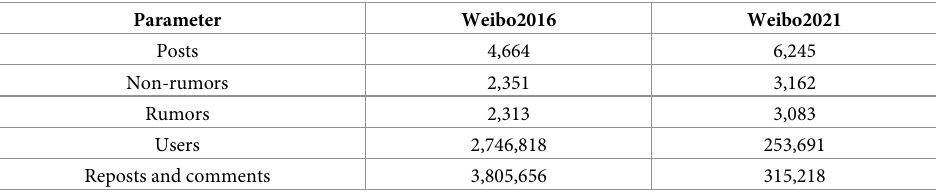
Table 1. Statistics of the Weibo2016 and Weibo2021